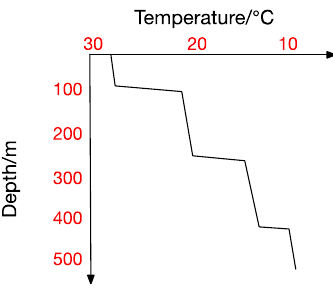
Figure 4. Multi-Thermocline.